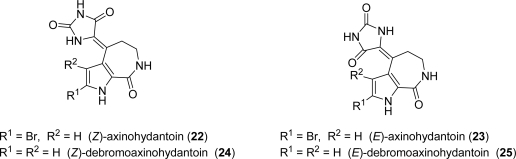
Axinohydantoins.